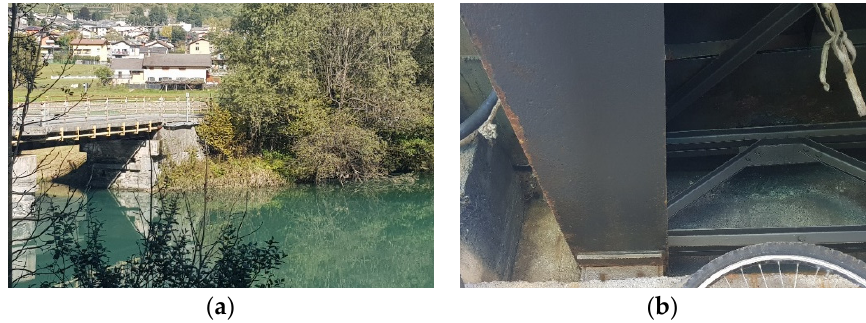
Figure 3. ( a ) View of the right embankment to access the bridge; ( b ) detail of rust signals.